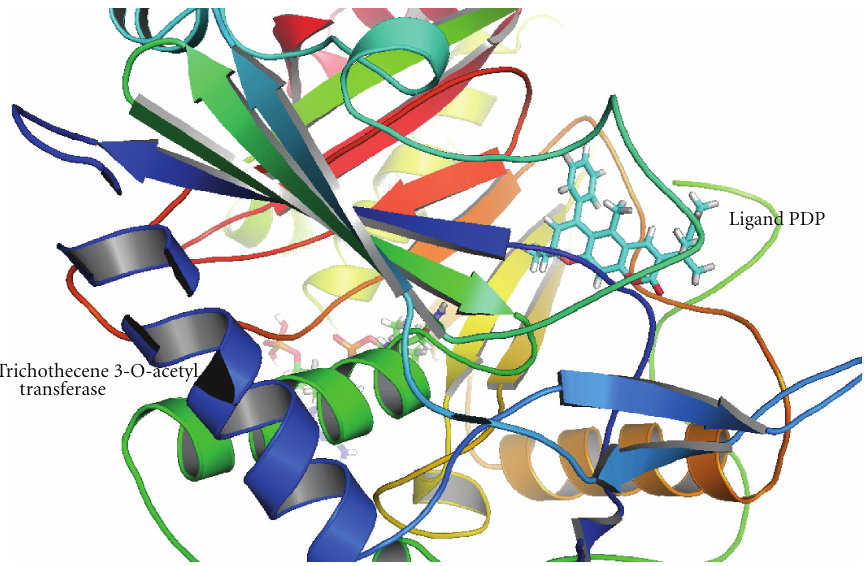
Figure 5: The docked complex of the ligand PDP in the active site residue cleft of the protein trichothecene